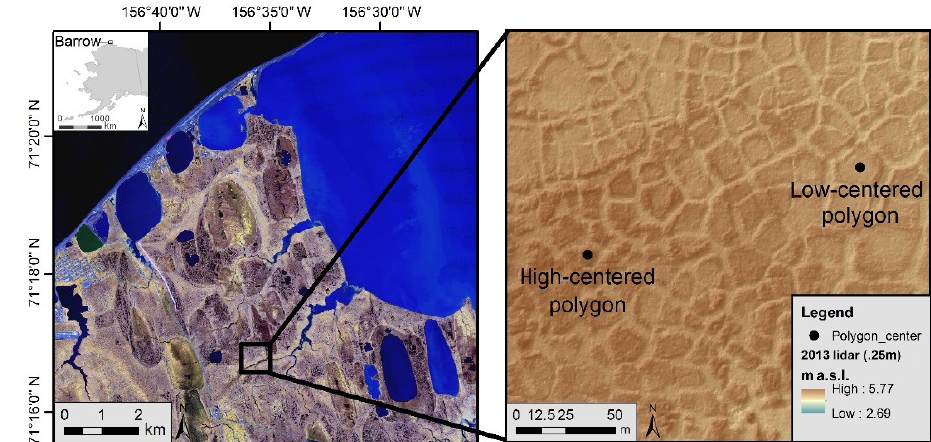
Figure 2. Map showing the portion of the Barrow Peninsula where the study was conducted (left) and a close-up of the area containing the low- and high-centered polygons used for the tracer study.